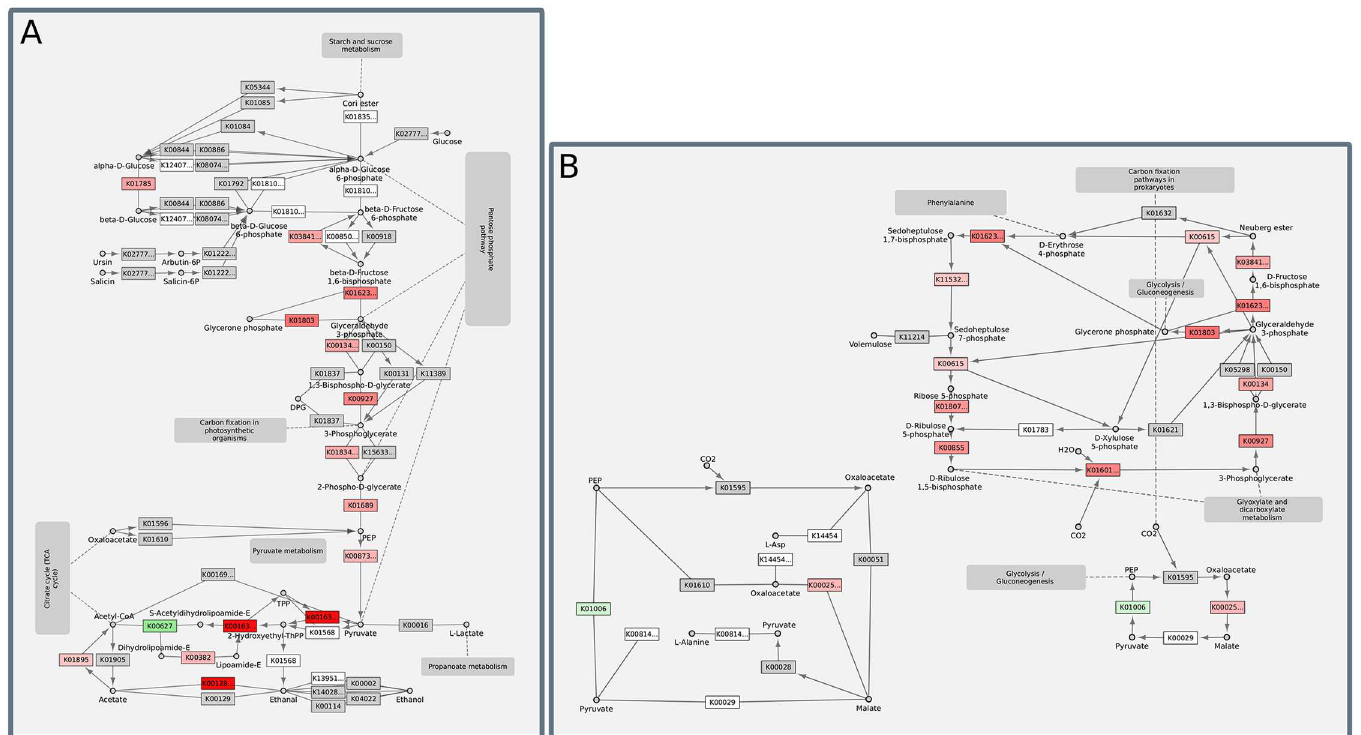
Fig 6. Enriched pathways in light vs. dark without silver (time point 3). Depictedare two KEGG metabolicpathways with a high enrichment in differentiallyexpressedproteins. (A) shows the glycolysis/glyconeogenesis and (B) carbon fixation in photosynthetic organisms. Significantly differentially expressedproteinsare coloured in red for a positive logFC and green for a negativelogFC. Proteins in white were identifiedwith quantitative MS, but did not show